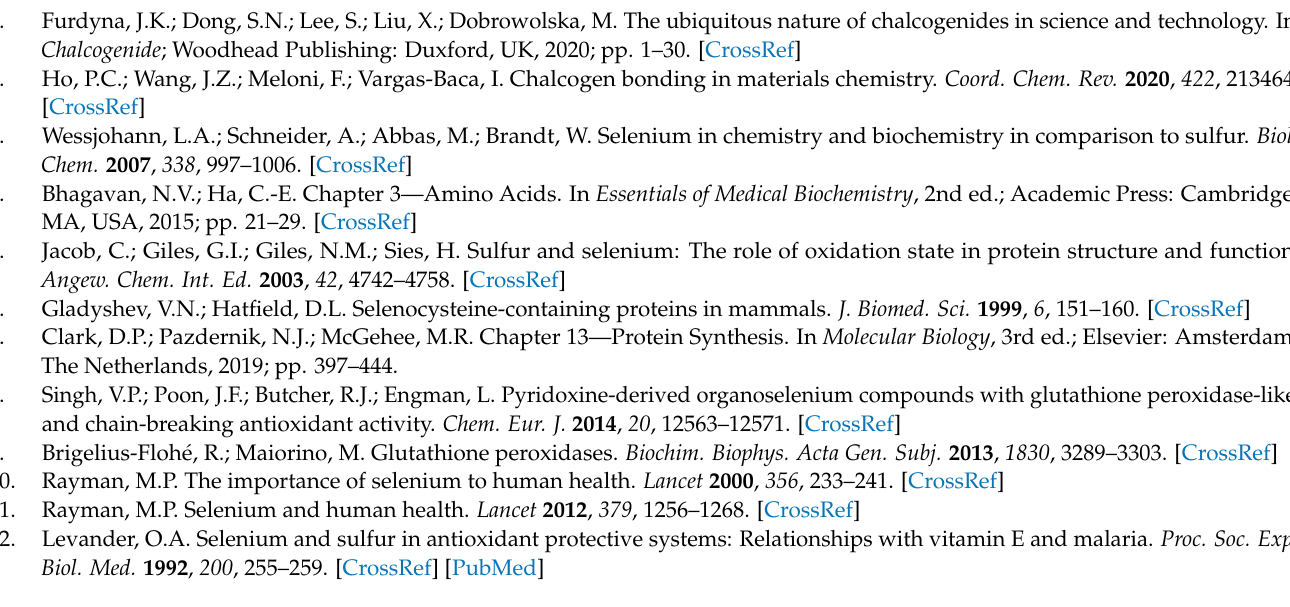
4 ; Table S1: Photoinduced activity of compounds 1 , 3 , 4 , and